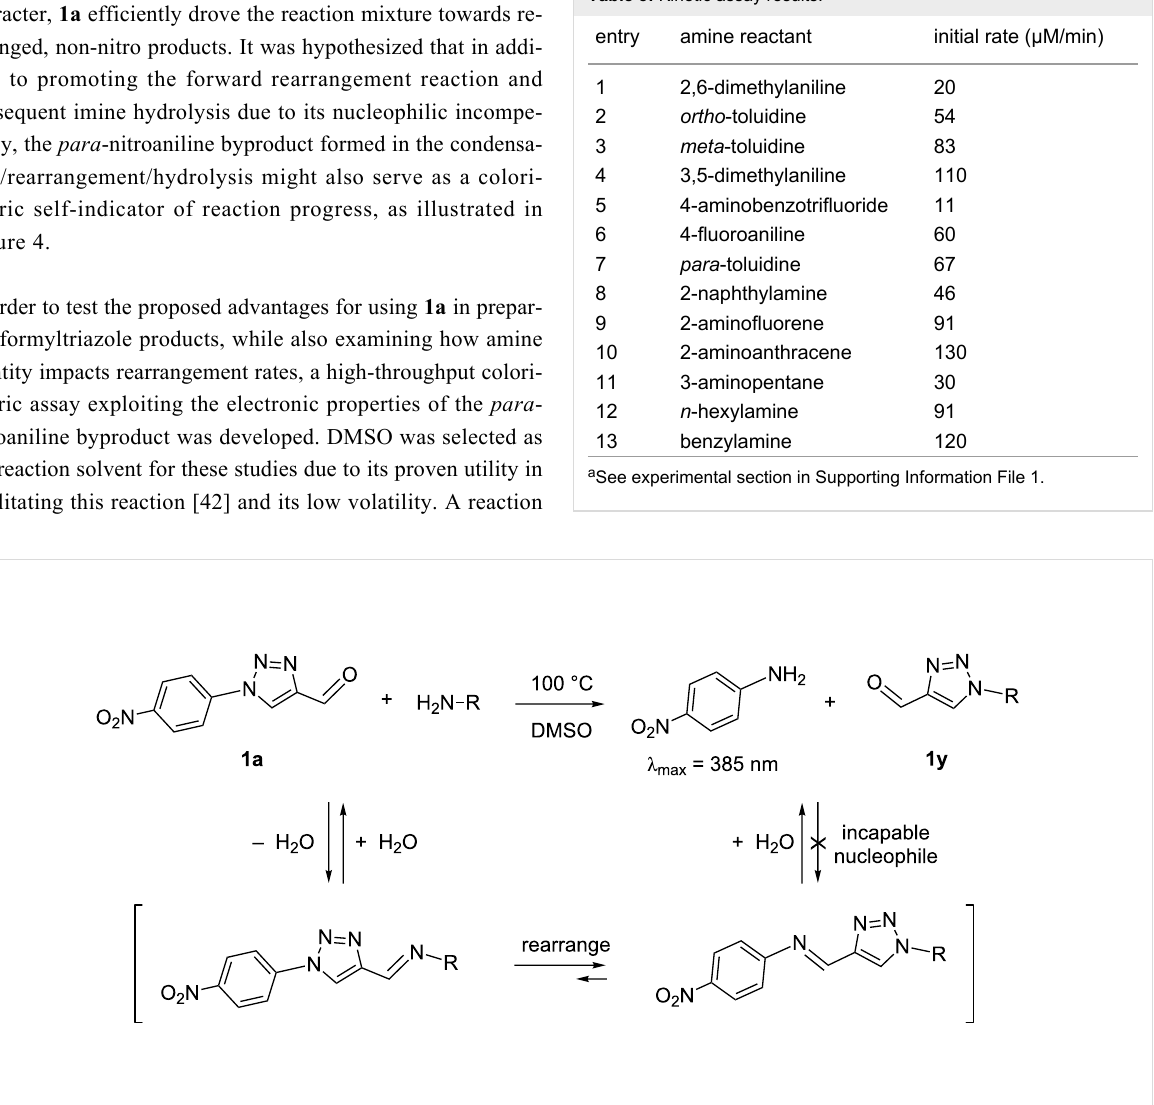
Table 3: Kinetic assay results.